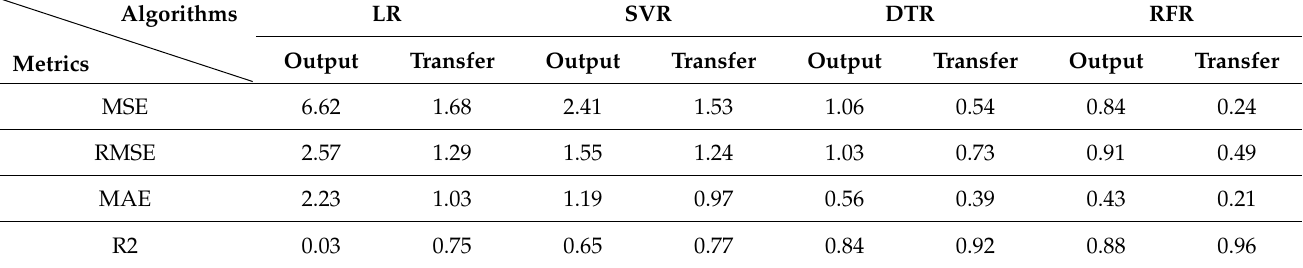
Table 1. Evaluation indicators of regression models obtained by LR, SVR, DTR and RFR algorithms.